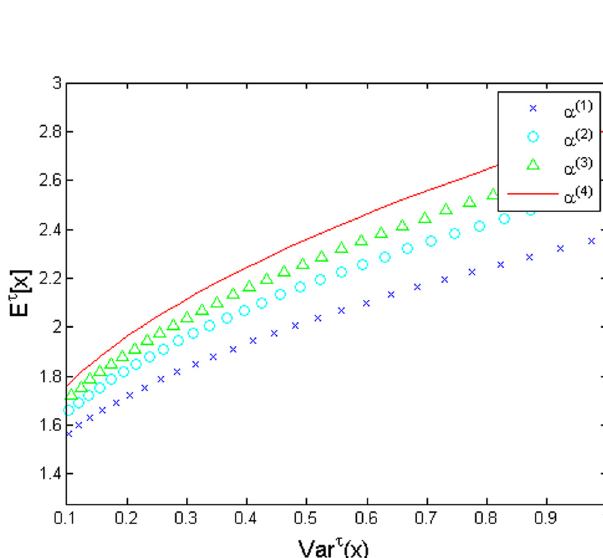
Figure 1: E ffi cient frontiers with di ff erent probability mass functions of exit